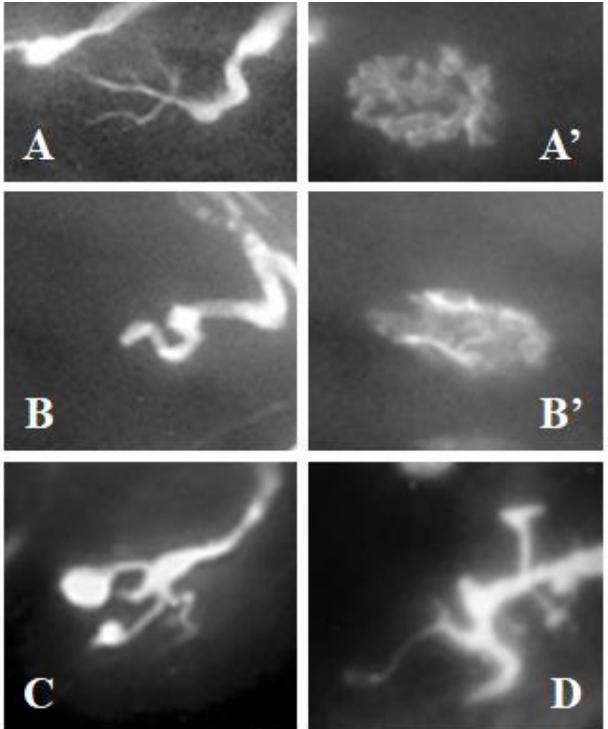
Figure 3. Neuromuscular junctions. The neurofilament (axon) was labeled with fluorescein ( A – D ) and post-synaptic receptors with α -bungarotoxin rhodaminated ( A’ , B’ ). ( A ) normal axonal ramification of a neuromuscular junction located over a healthy muscle fiber. ( A’ ) normal postsynaptic component corresponding to the axon displayed in ( A ). ( B ) completely retracted axon; note that no axonal ramification can be identified, but it is notably thickened. ( B’ ) postsynaptic-destructured component corresponding to the axon displayed in ( B ). ( C ) axon displaying some of its branches with distal bulbs that are characteristic of axonal retraction. ( D ) axon showing some of its branches notably thickened, characteristic of axonal retraction. The images shown in ( B – D ) correspond to LAL muscles after 72 h of injecting bupivacaine. Initial enlargement is 200 × in all